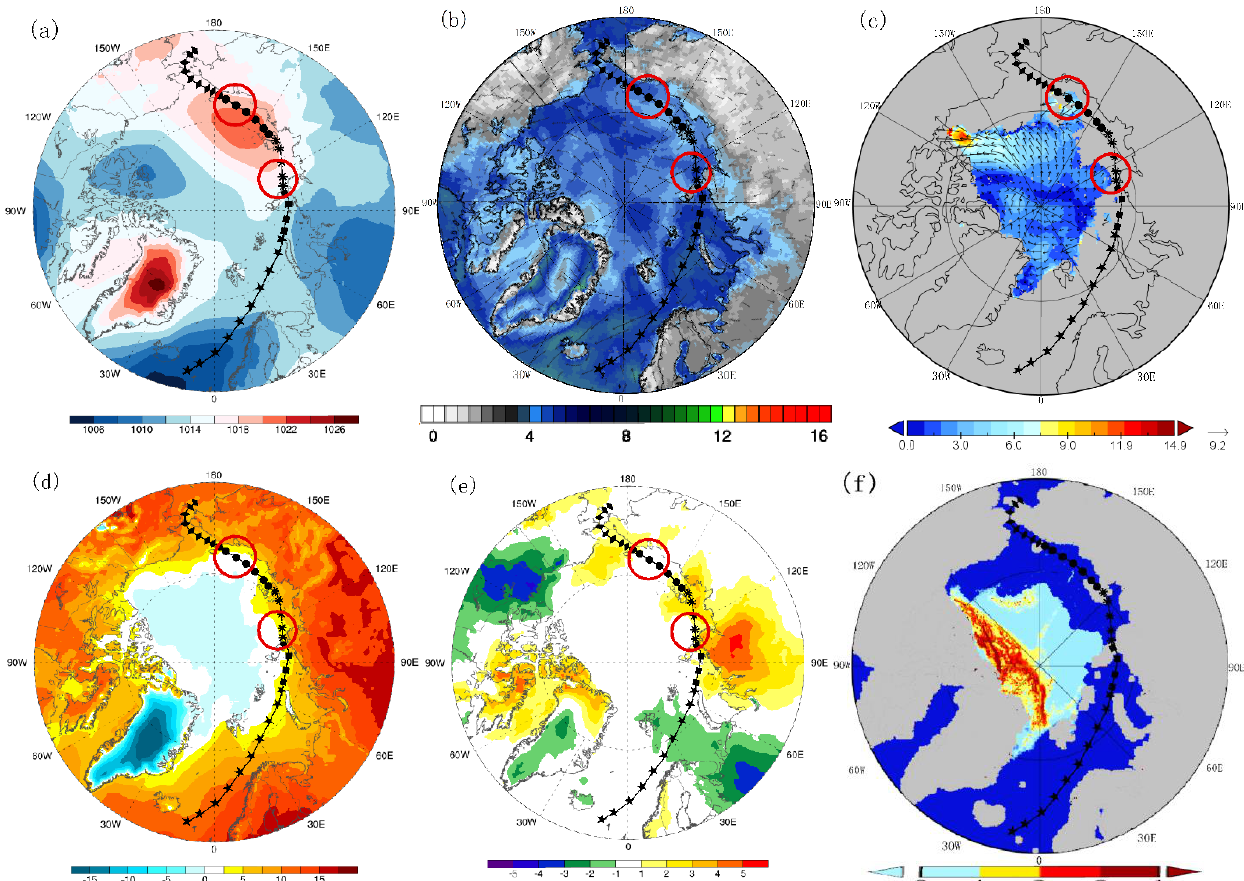
Figure 17. Distribution map of ( a ) sea level pressure (unit: hpa); ( b ) wind field (unit: m − 1 ); ( c ) sea ice movement (unit: m − 1 ); ( d ) temperature (unit: centigrades); ( e ) temperature anomaly (unit: centigrades) and ( f ) sea ice age (unit: year) in the Arctic summer in August 2019. (The red circles represent the special areas.)